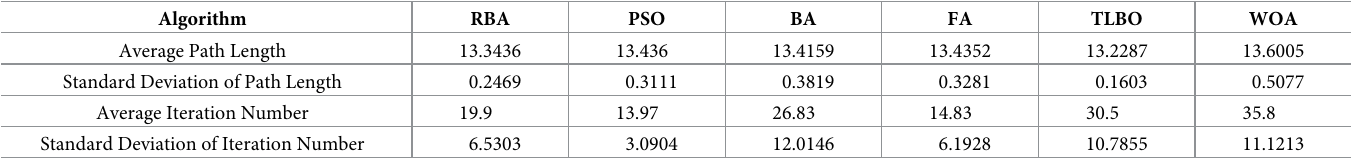
Table 4. Performance comparison between RBA and classical optimization algorithms in test case